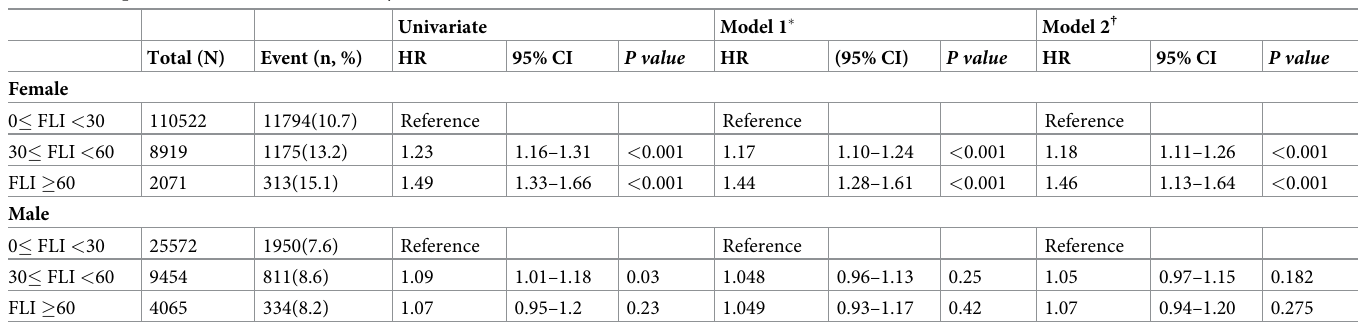
Table 3. Sex specific associations between fatty liver index and incidence of